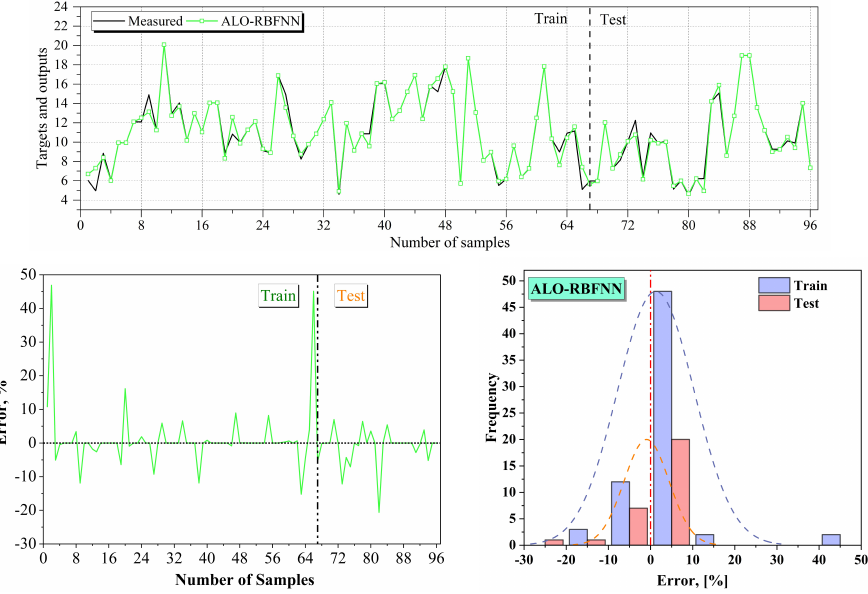
Fig. 9. Train and test stage results of the introduced ALO-RBFNN model in predicting